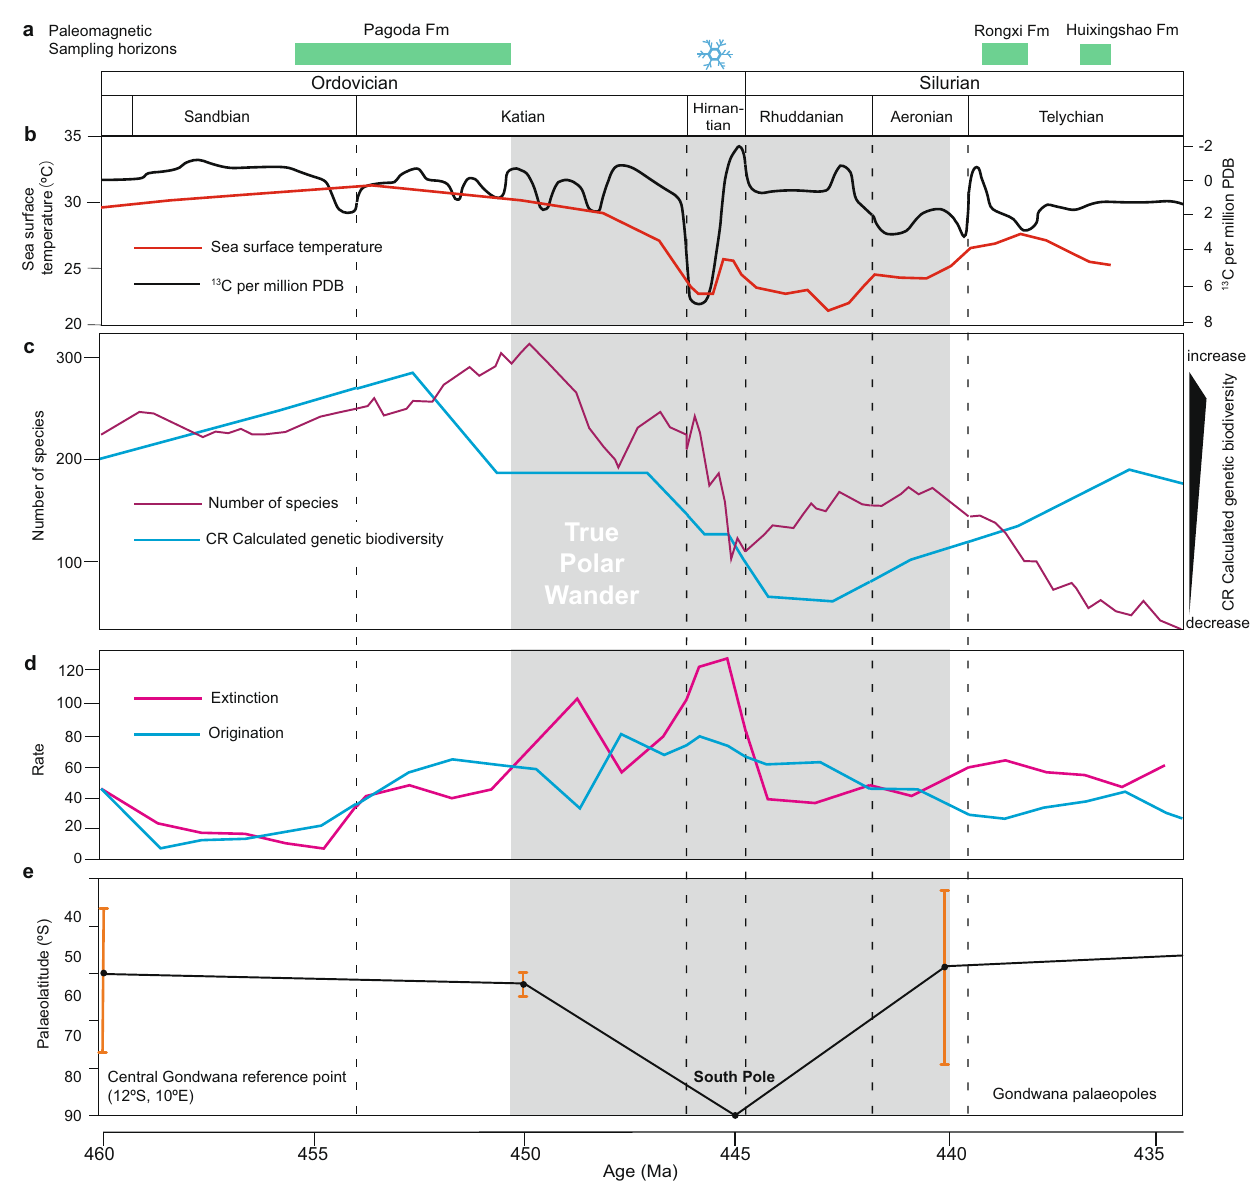
Fig. 6 | Late Ordovician – early Silurian global change and true polar wander. a Temporal distribution of the palaeomagnetic sampling horizons by Formation (Fm) from South China. Snow fl ake above the Hirnantian stage indicates the age of short, sharp glacial advance 3 . b δ 13 C record (black) and sea surface temperature variation (red) from Rasmussen et al. 7 c Biodiversity during the Sanbian – Telychian stages from Deng et al. 11 (purple line) and Rasmussen et al. 7 (blue line). CR